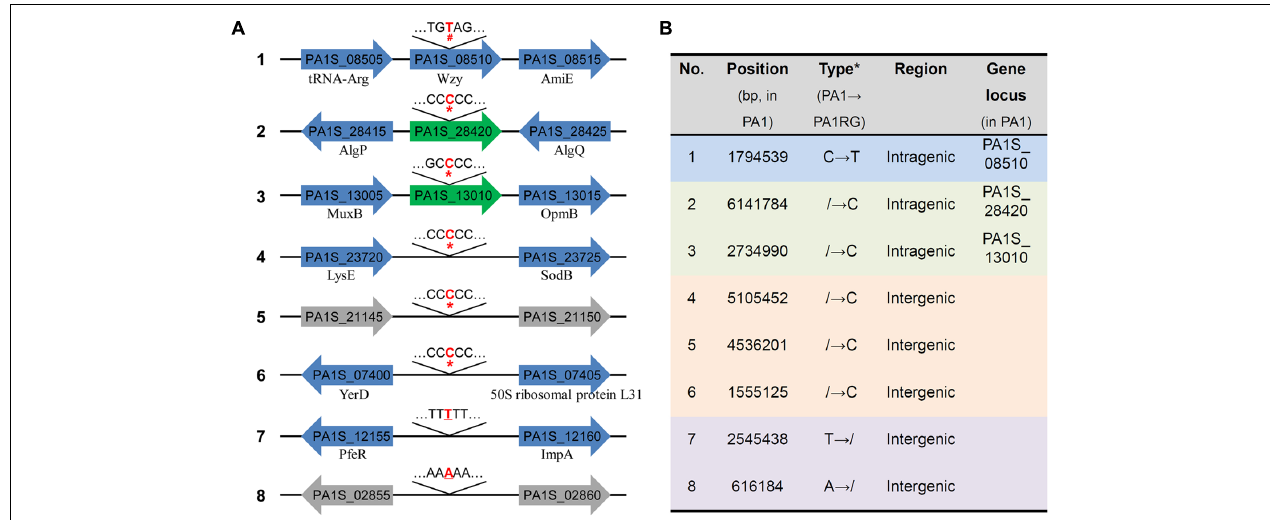
FIGURE 3 | Genetic variations identified within the PA1RG genome. (A) Diagram of mutations of the PA1RG genome sequence. Mutated nucleotides were labeled as red and bold letters, the symbol of # , ∗ , and underline indicates nucleotide substitution, insertion, and deletion, respectively. Green arrows represent pseudo genes, gray arrows represent genes encoding hypothetical protein, blue arrows represent functional genes and products are labeled underneath. Genes were not drawn to the scale. (B) Summary of genetic variations within the PA1RG genome. ∗ The symbol of/indicates absence of nucleotide in corresponding genomic site.